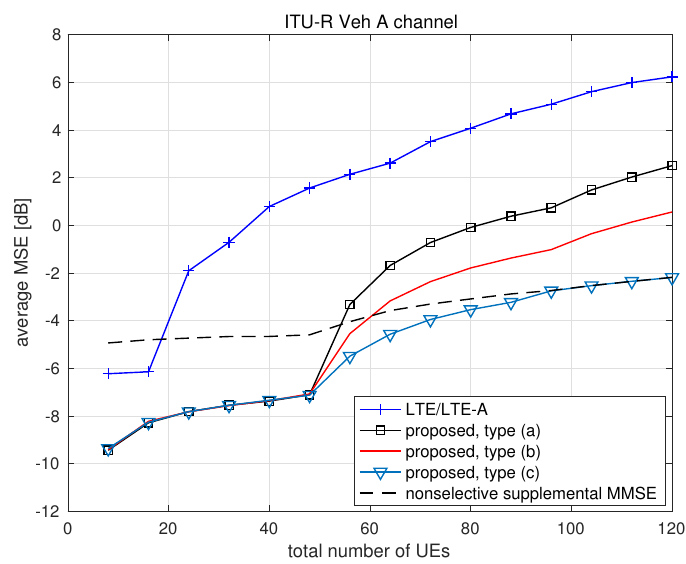
Figure 5. Average MSE of channel estimation with respect to the total number of UEs over ITU-R Veh A